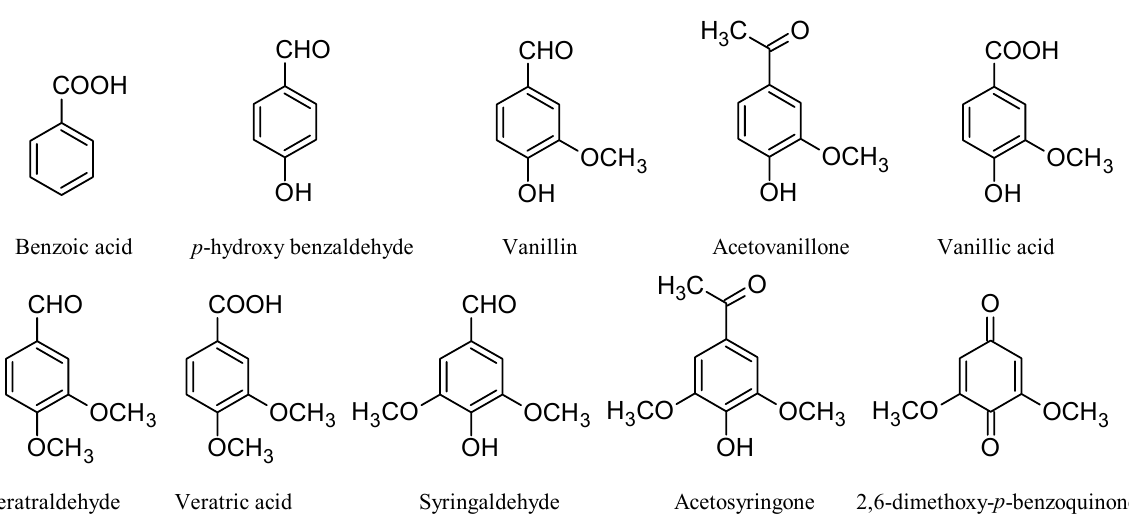
Figure 6. Low-molecular weight compounds identified in softwood and birch kraft pulp POM solution